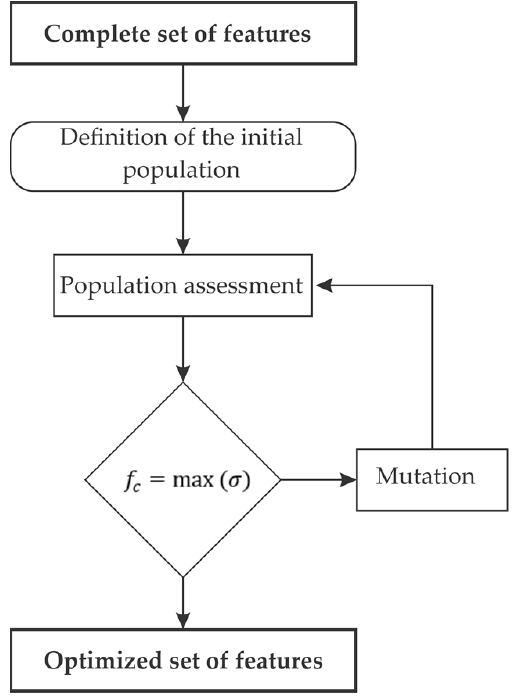
Figure 4. Flow chart for the GA implementation.